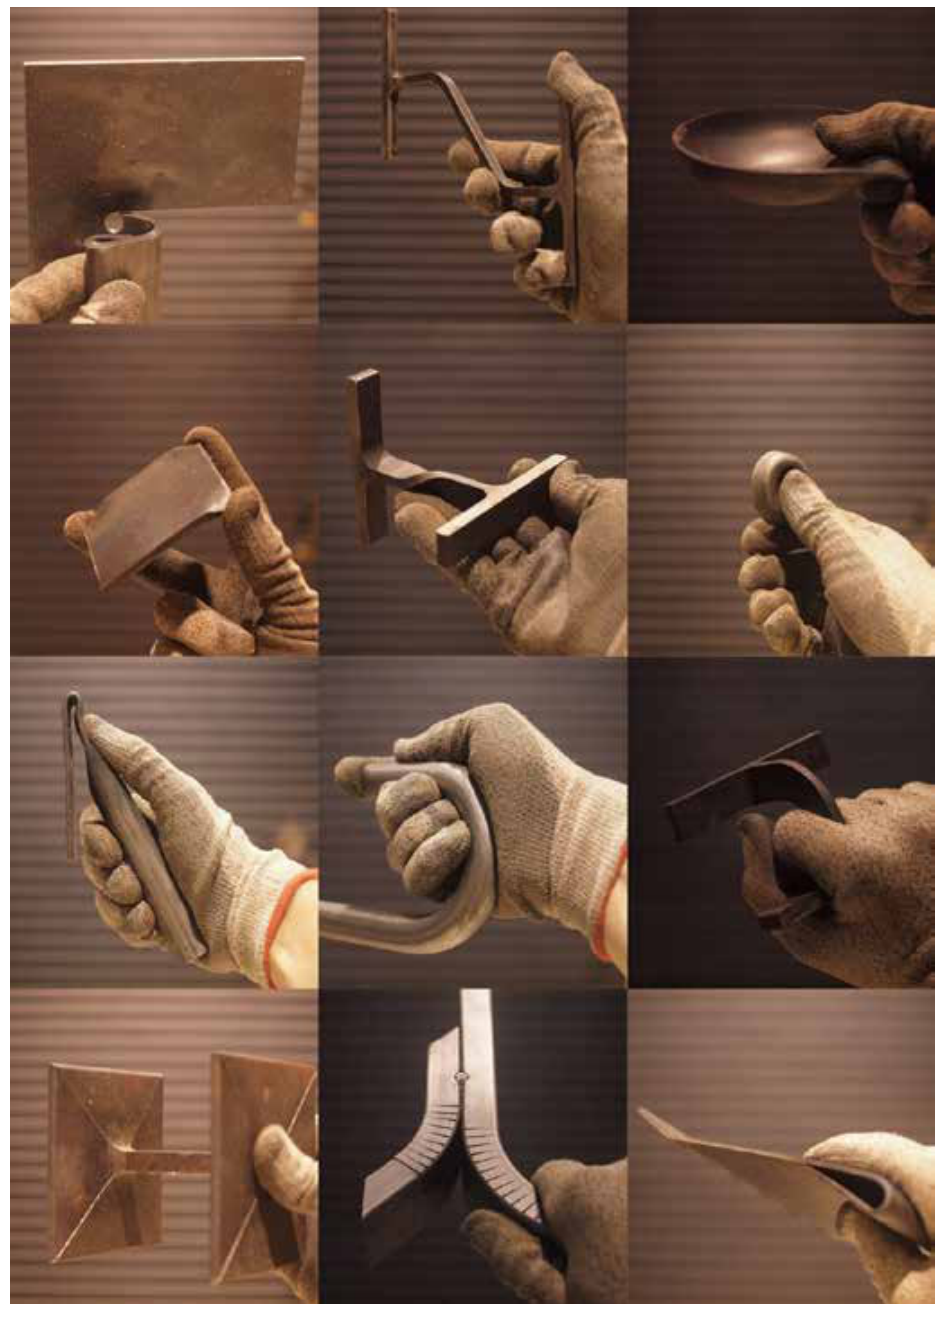
Figure 6: Thinking in steel. A study working with materials for simple manual tools: heat, hammer, anvil, and saw. Some sketches sought to transform recognisable architectural elements into discrete objects. Further steps are needed to address the completion and operational uses. Ideally their familiarity stays intact, with accustomed origins obscured. Source: